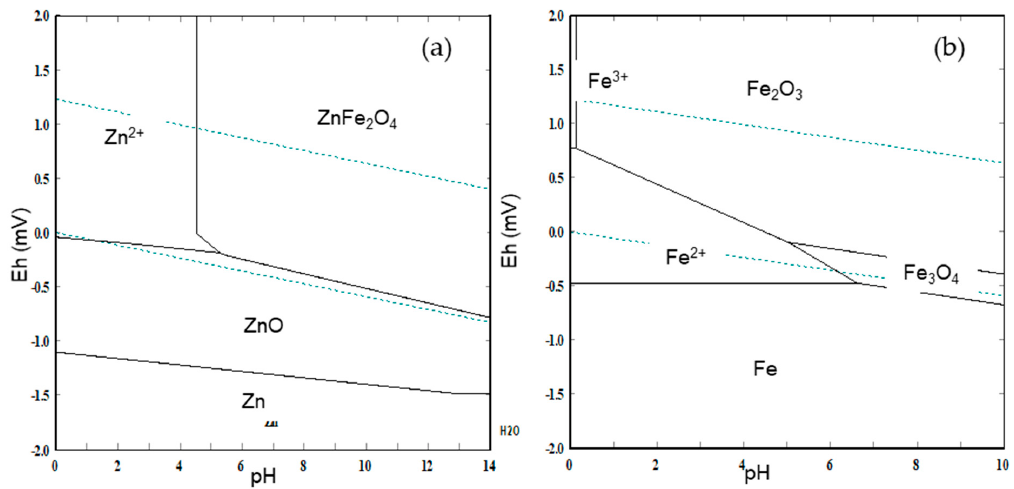
Figure 9. Eh–pH diagrams. ( a ) Zn–O–S system and ( b ) Fe–O–S system; under standard conditions at 25 °C [31].